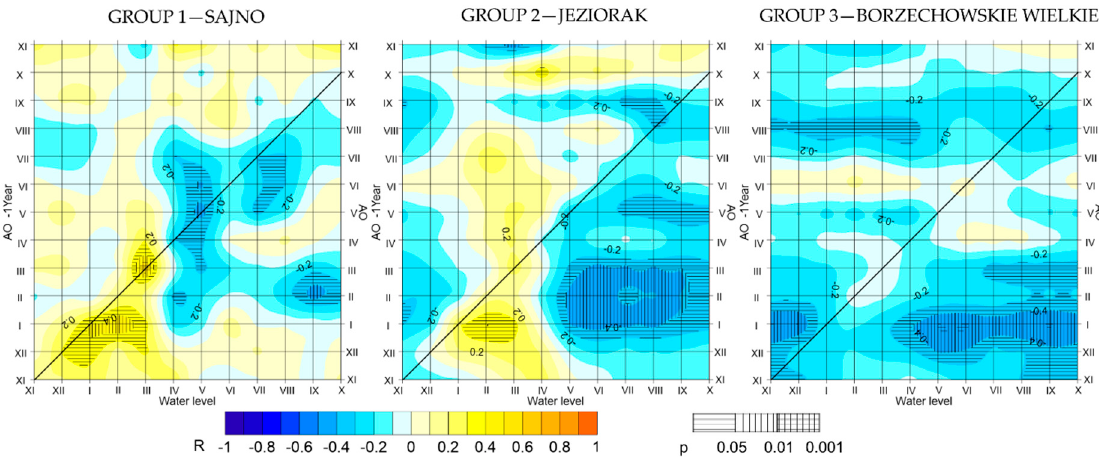
Figure 3. Matrices of coefficients of correlation for selected lakes in the designated groups (AO).